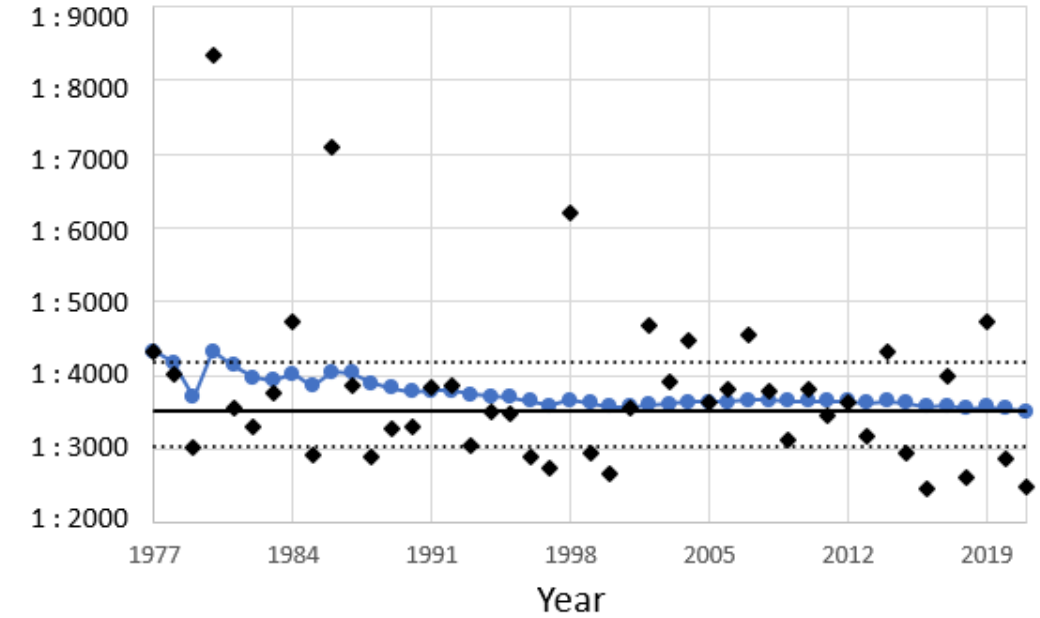
Figure 3. Incidence of CH in Switzerland from 1977 to 2021. (cid:7) Incidence per year; • cumulative incidence from 1977 to the respective year; ― total incidence from 1977 to 2021; …. 95% CI of the total incidence.